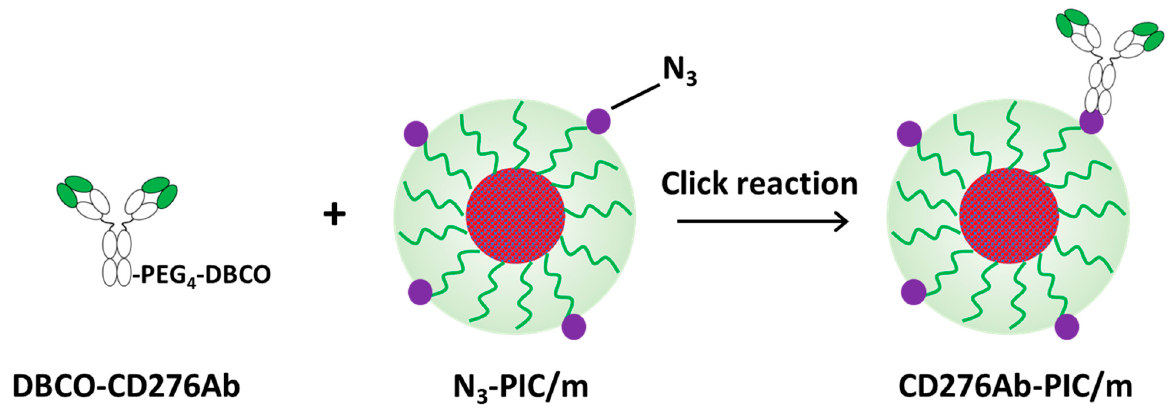
Figure 1. CD276Ab installation to N 3 -PIC/m by click reaction.